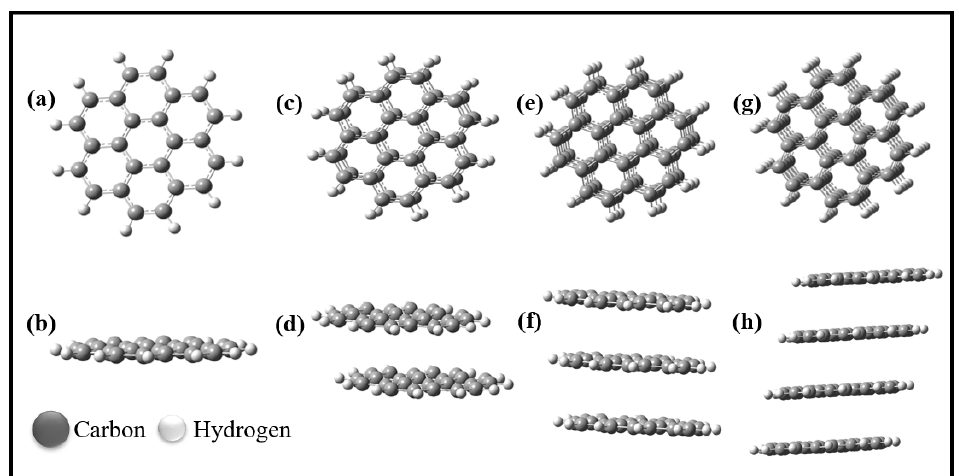
Figure 1. Optimized structures of ( a , b ) monolayer graphene sheet (MG), ( c , d ) bilayer graphene sheet (BG), ( e , f ) trilayer graphene sheet (TG), and ( g , h ) tetralayer graphene sheet (TTG). ( b , d , f , h ) Side-view orientation of the graphene sheets.